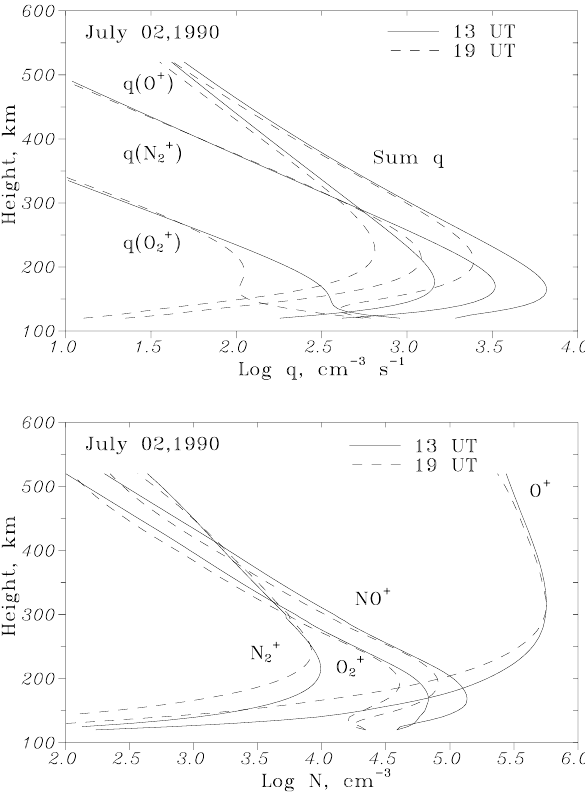
Fig. 9. Calculated height profiles of photo-ionization rates and cor- responding ion concentrations for daytime (13 UT) and evening (19 UT) hours. Note the strong decrease in the photo-ionization rates at lower heights in the